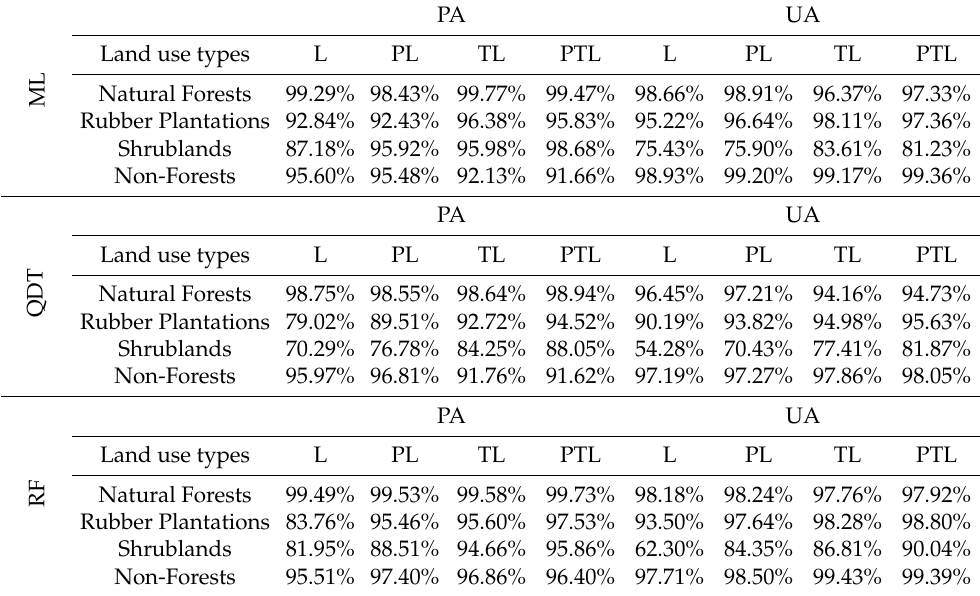
Table 2. The producer’s accuracy (PA), user’s accuracy (UA), kappa coefficient (KA), and overall accuracy (OA) in 2020 of three classifiers with four kinds of data input: Landsat spectral bands (L), phenology–Landsat spectral bands (PL), topography–Landsat spectral bands (TL), and phenology–topography–Landsat spectral bands (PTL).